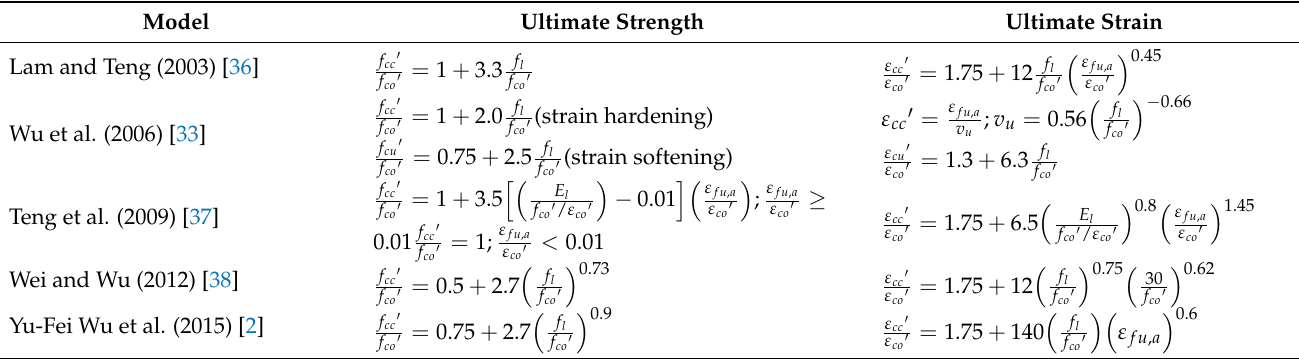
Table A1. Existing models of FRP-confined concrete evaluated in this